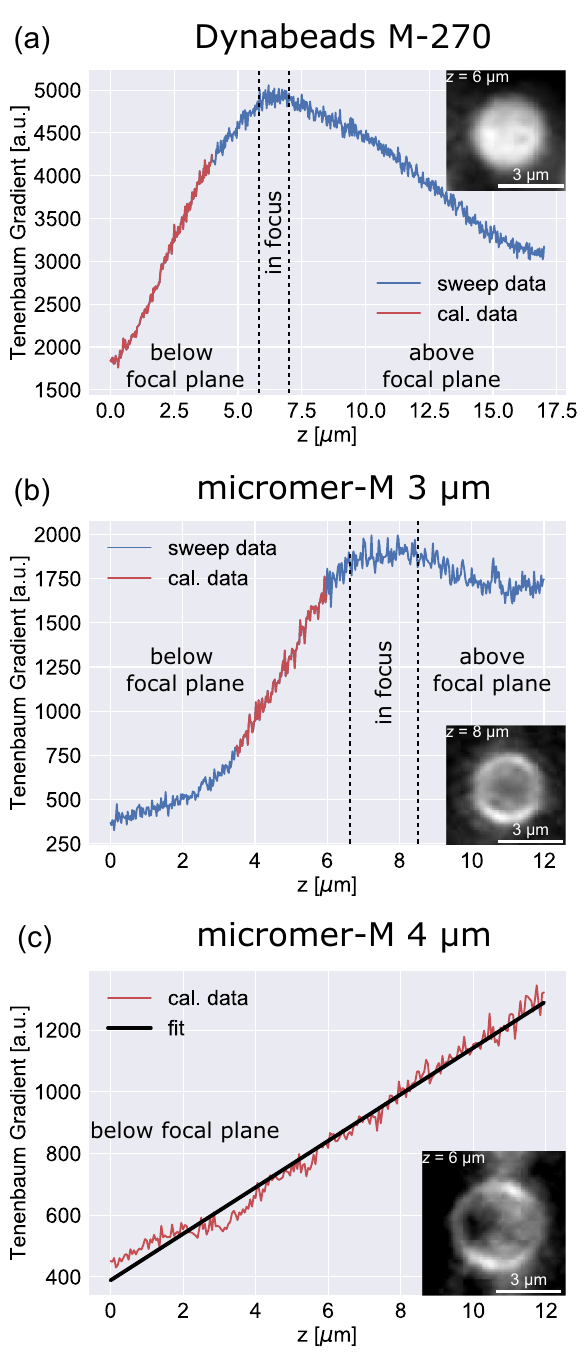
Figure 2. Exemplary focus sweep data for determining the z -position of SPPs within a microfluidic transport system. Curves ( a – c ) show the TBG, as a measure for particle sharpness, in dependence on the set z -position of the SPPs with respect to the focal plane. The data was acquired by sweeping the sample through the focal plane of the used microscope (starting with a position below the focal plane) in 25 nm steps for Dynabeads M-270/micromer-M 3 µm, and in 50 nm steps for micromer-M 4 µm, recording reference images at every step. Curves ( a ) and ( b ) show the general progression of TBG for different z -position regimes (below, within, and above the focal plane) and demonstrate that the chosen approach for evaluating the particle sharpness is suitable for different types of SPP. The regions of highest sensitivity (steepest slope) for z -position detection with approximately linear progression are highlighted in red. For micromer-M 4 µm SPP ( c ), only the linear regime of the highest sensitivity focus sweep data is displayed which was taken for further particle transport experiments as the z -position calibration. Exemplary background-subtracted images of the respective SPP at the indicated z -position are shown in the insets of each